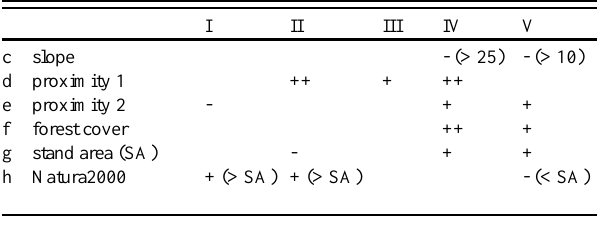
Table 3 . Qualitative weighting factors a (Eq. 1) for effect of a factor on suitability. + indicates a minor positive effect, - indicates a minor negative effect, and ++ indicates a major positive effect. For step functions, the cut-off point is given in brackets. FMA I: nature reserve, II: close-to-nature, III: combined objective, IV: even-aged forestry, V: short